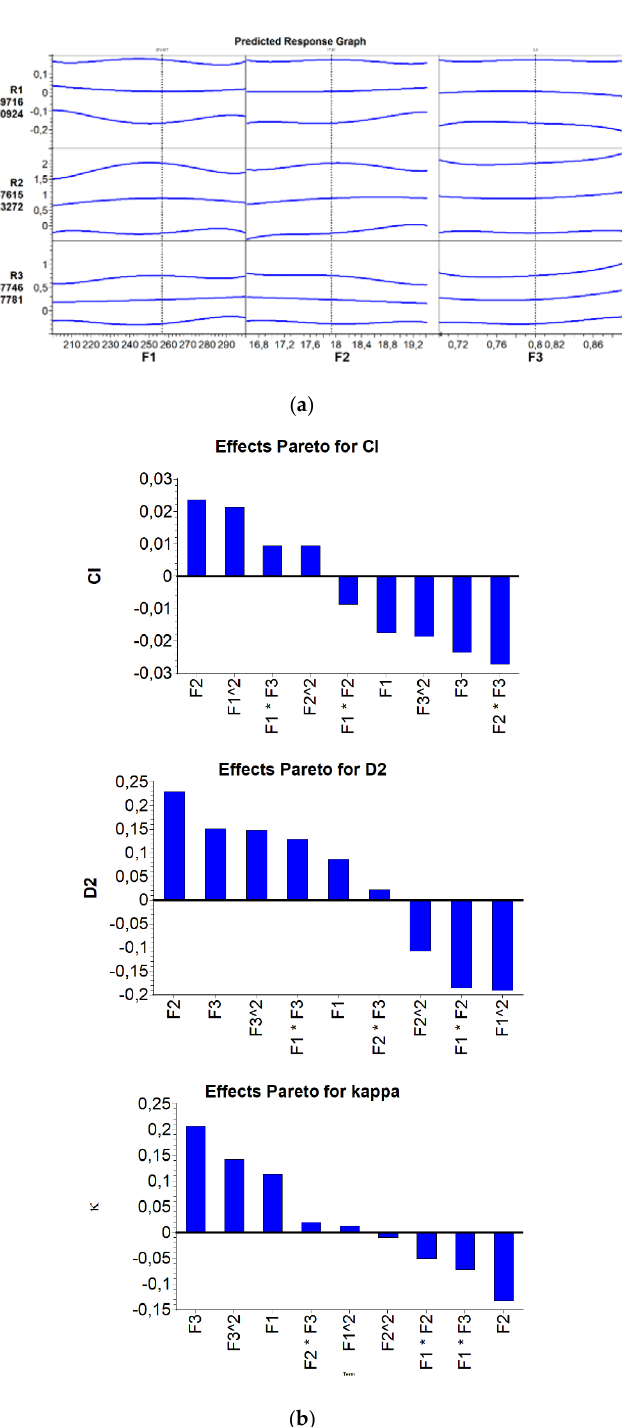
Figure 5. ( a ) Predicted Response Graph for R1 to R3 vs. F1 to F3. ( b ) Influence of factors on the response C I (top), D 2 (middle), and κ